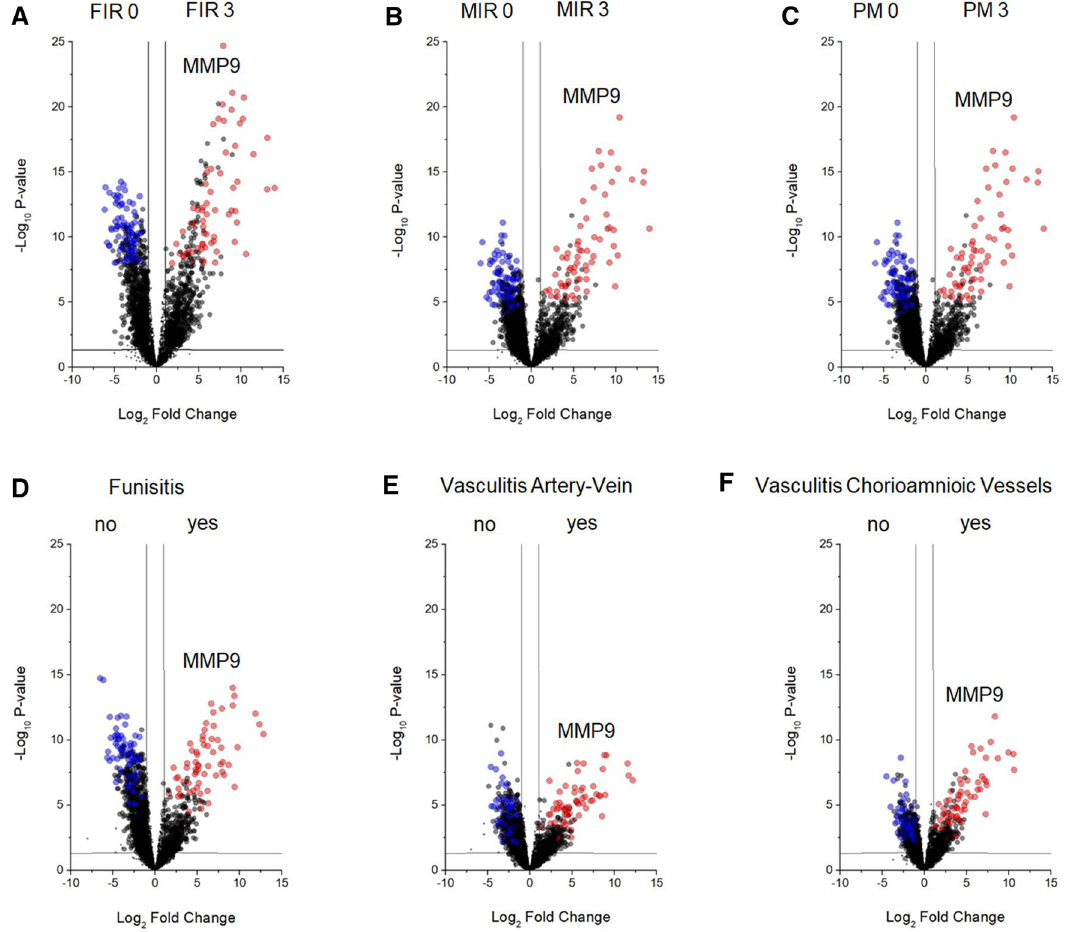
Figure 2. Volcano plots of all comparison. Volcano plot for ( A ) FIR 0 vs FIR 3; ( B ) MIR 0 vs MIR 3; ( C ) PM 0 vs PM 3; ( D ) absence vs presence of funisitis; ( E ) absence vs presence of umbilical artery or vein vasculitis; ( F ) absence vs presence of vasculitis of chorioamniotic vessels. Black, blue and red circles indicate the changes for the non-significant or significant of previously described groups, respectively. Black line indicates the limits of statistically significant. Black circles above the black line indicate the proteins with an identity <